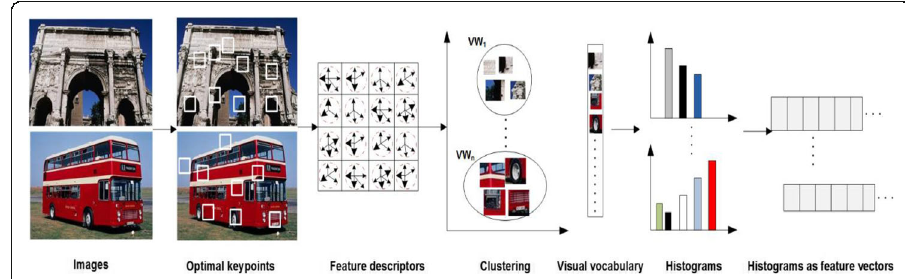
Fig. 2 The BoVW model-based visual representation of the images